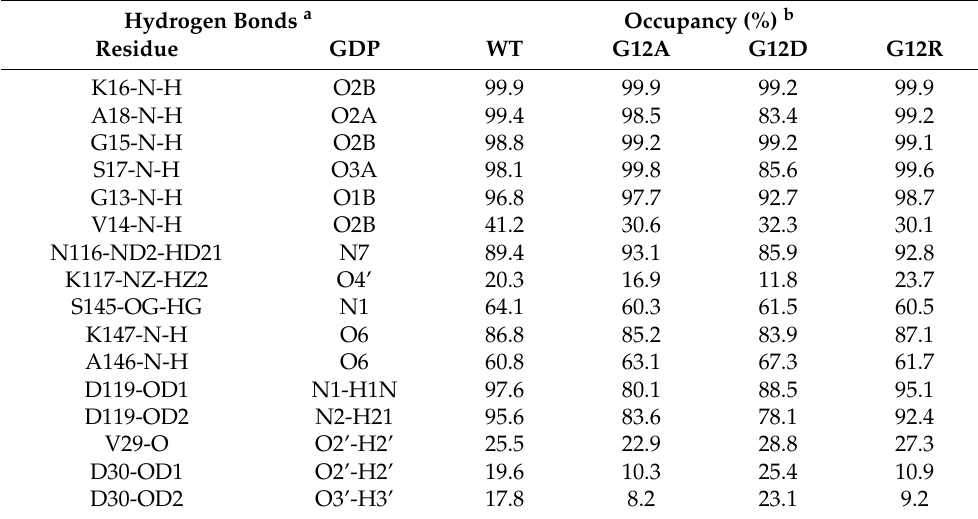
Table 1. HBIs of GDP with KRAS revealed through the program